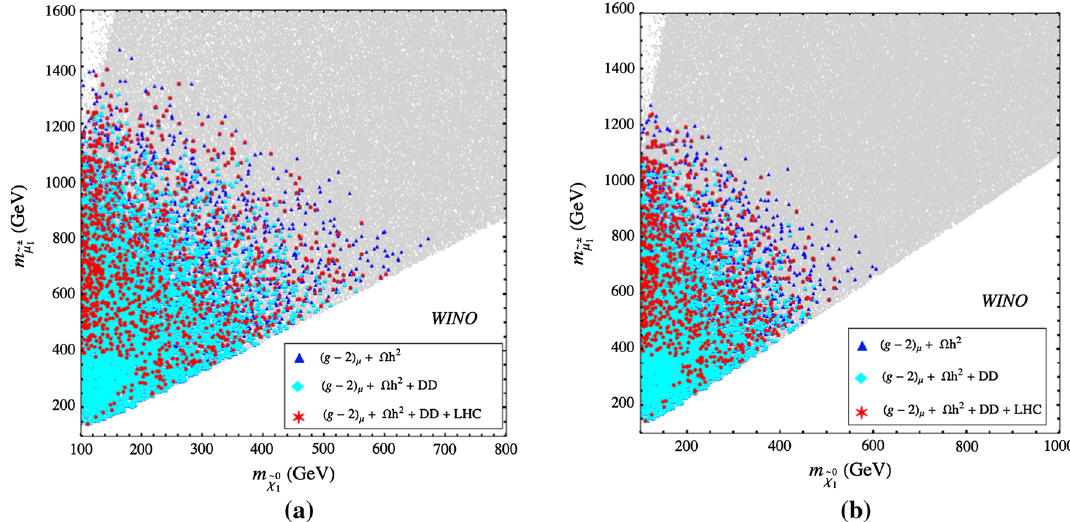
Fig. 9 The results of our parameter scan in the m ˜ χ 0 from ( g − 2 ) μ . The color coding is as in Fig. 6